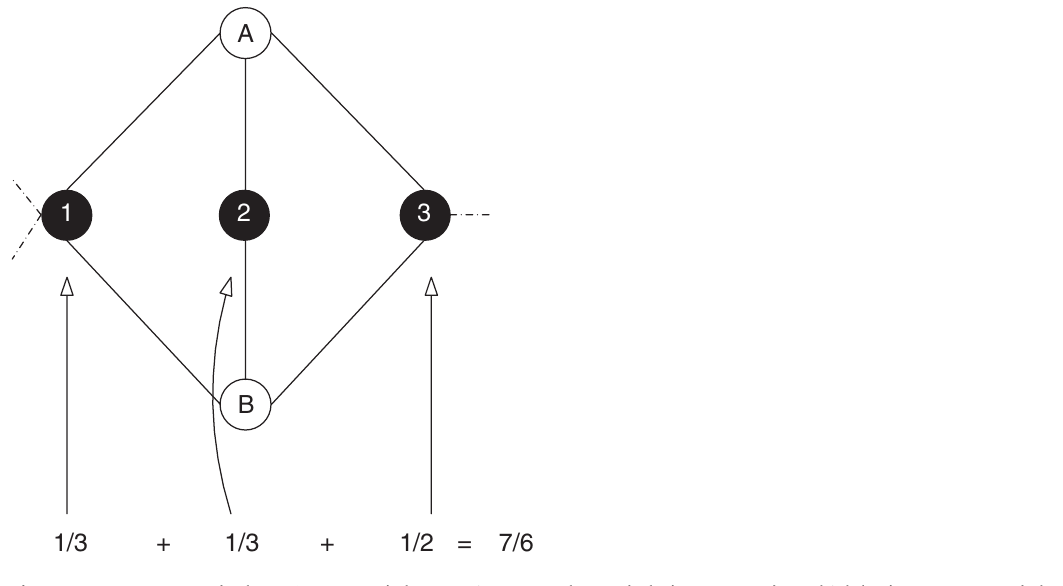
Figure 3: Partners A and B have Cooperated Three Projects Together, Labeled as 1, 2, and 3, Which had Four, Four, and Three Authors,